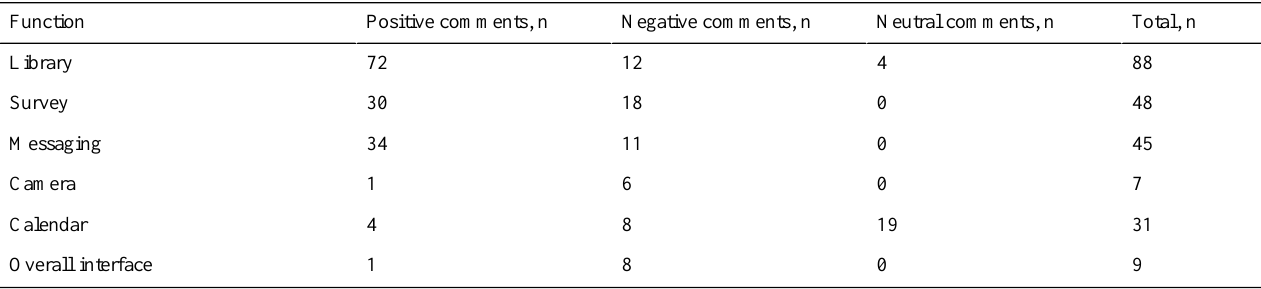
Table 2. Perception of the Personal Health Network by